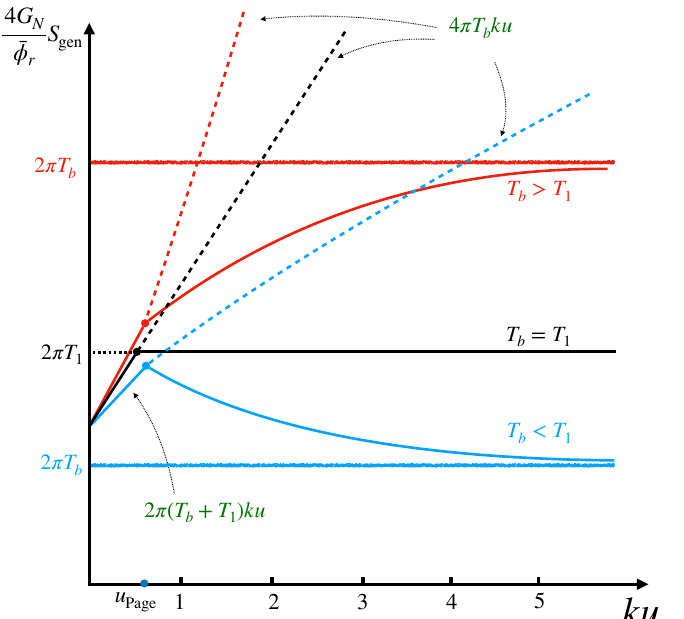
Figure 11 . The schematic diagram for Page curve of black hole coupled with a thermal bath at different temperatures. The red, black, and blue solid lines show the Page curve for a growing black hole with T b > T 1 , an external black hole at equilibrium status with T b = T 1 , and an evaporating black hole with T b < T 1 , respectively. The corresponding dashed lines present the generalized entropy at the late-time region, whose behavior is dominated by the linear term 4 πT b ku as discussed around